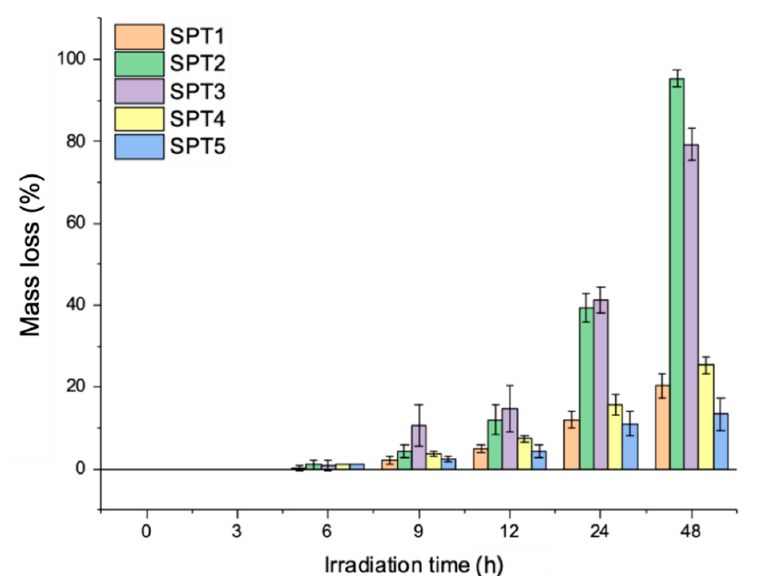
Figure 8. Degradation of PA66 microfibres under UVC with di ff erent concentrations of catalyst for 48 h. SPT1 = TiO 2 (0 mg / L); SPT2 = TiO 2 (100 mg / L); SPT3 = TiO 2 (500 mg / L); SPT4 = TiO 2 (1000 mg / L); SPT5 = TiO 2 (20,000 mg / L). Error bars = standard deviation of a triplicate. The average initial mass of the PA66 microfibres was 1.27 mg. Table 4. Apparent reaction constant ( (cid:2018) (cid:3028)(cid:3043)(cid:3043) ) and half-life (t 1/2 ) calculated for SPT1 to SPT5, where different concentrations of TiO 2 from 0 to 20,000 mg/L were used.